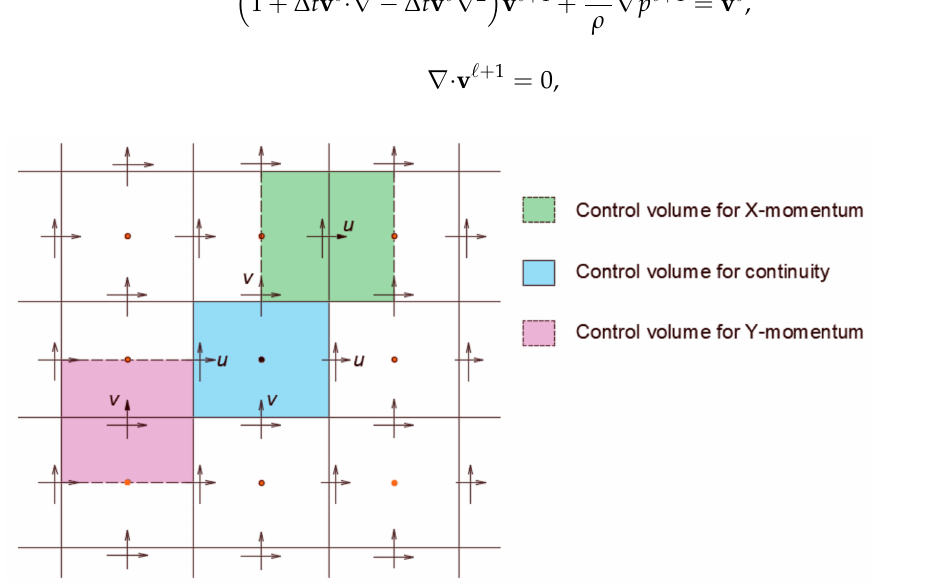
Figure 4. Schematic of the staggered grid for the three